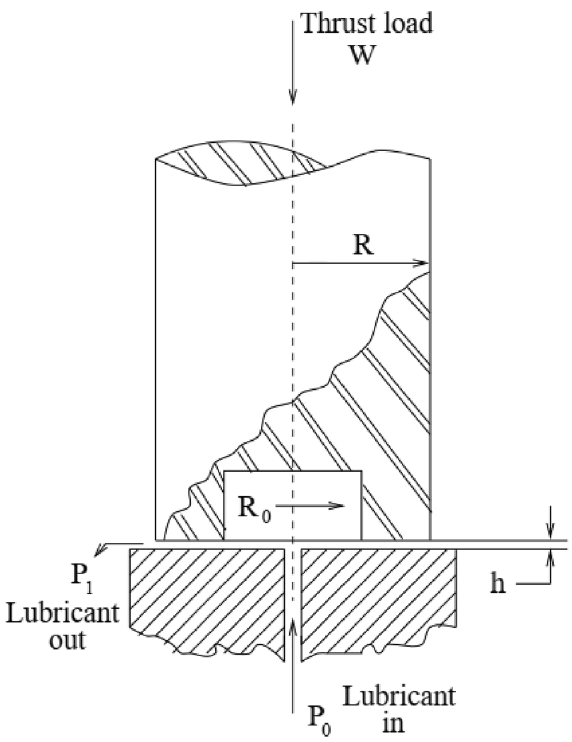
Figure 9. Schematic view of the hydro-static thrust bearing 66